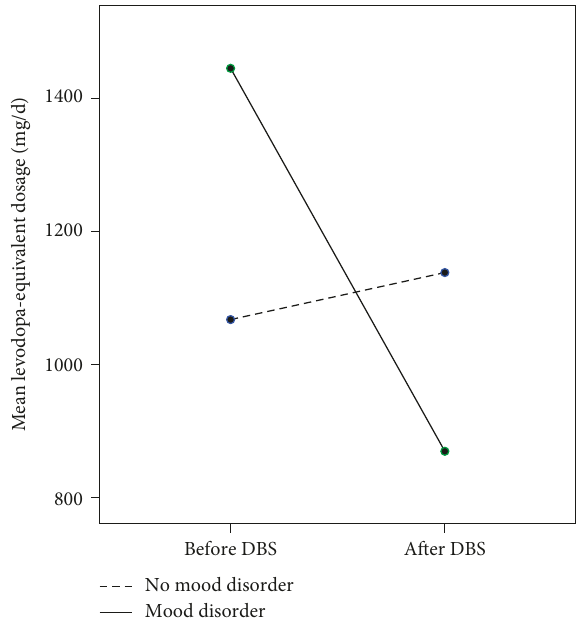
Figure 2: Mean levodopa-equivalent dosage of patients before and after DBS in patients split according to subsequent onset of mood